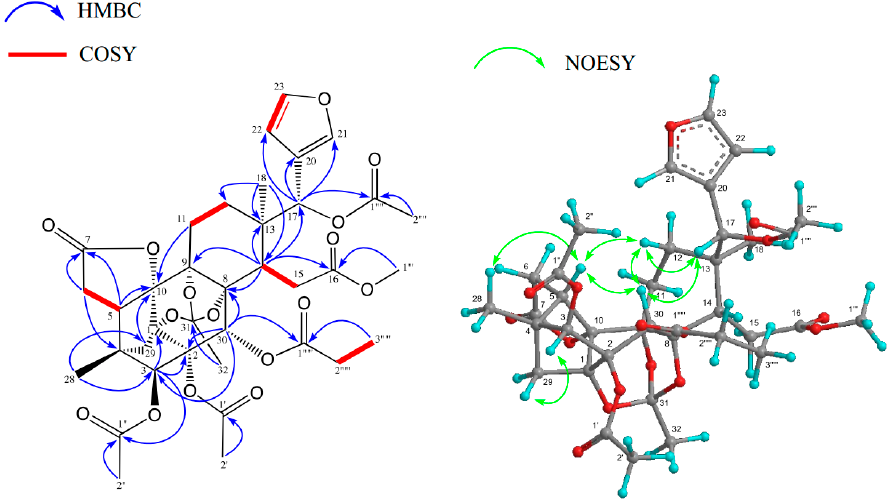
Figure 2. Key HMBC, COSY, and NOESY correlations of Carapanosin D ( 1 ).